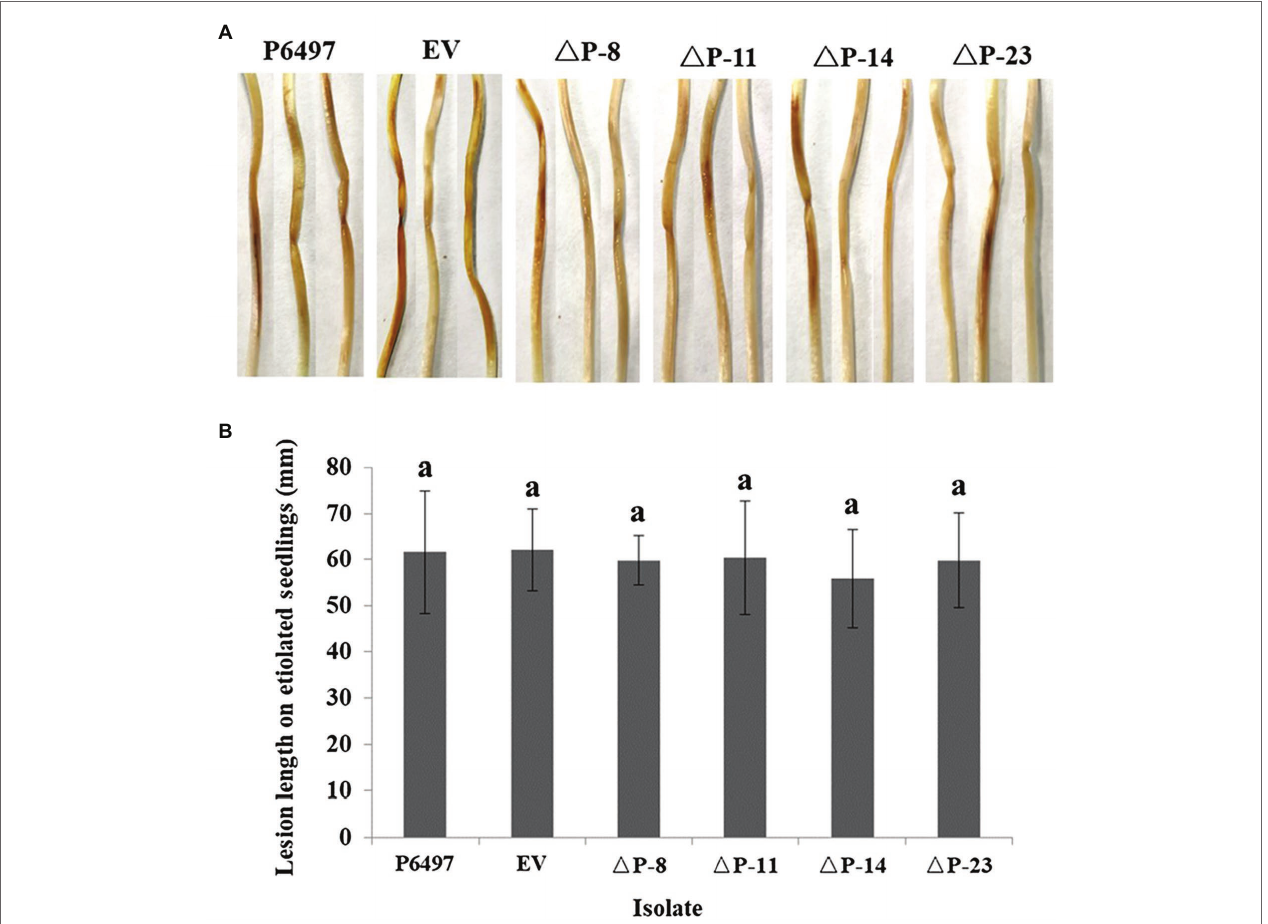
FIGURE 6 | Virulence of PsPTL mutants. (A) Lesions on etiolated soybean hypocotyls. (B) Lesion length on etiolated soybean seedlings. Columns indicate means, and bars show SDs. The same letters above the columns signify statistically insignificant difference ( p <